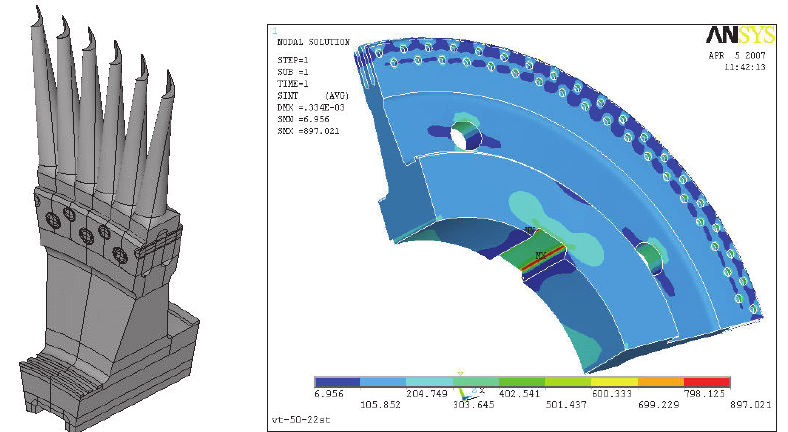
Figure 2: Equivalent stress distribution for turbine disk.